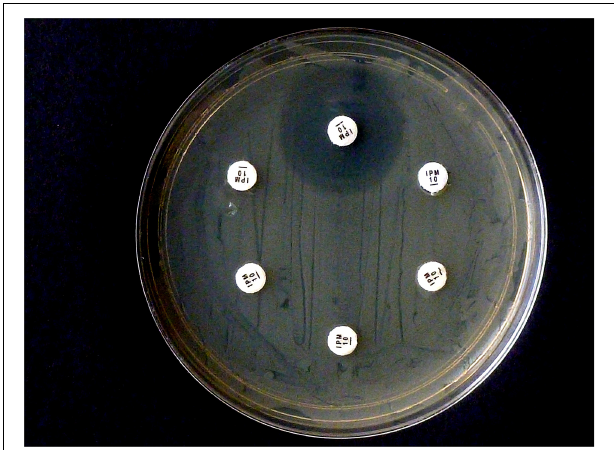
FIGURE 2 | Results from carbapenem inactivation method CIM with imipenem. Tested isolates were (in clockwise sequence): E. coli ATCC 25922 (top), E. coli OXA-48 (No. 16), E. kobeii AmpC (No. 79), K. aerogenes AmpC (Nos. 60, 61, 62). A positive test arises when the antibiotic is hydrolyzed (inhibition diameter 6 mm) after exposure for 2 h at 35 ◦ C. Indicator strain was E. coli ATCC 25922.